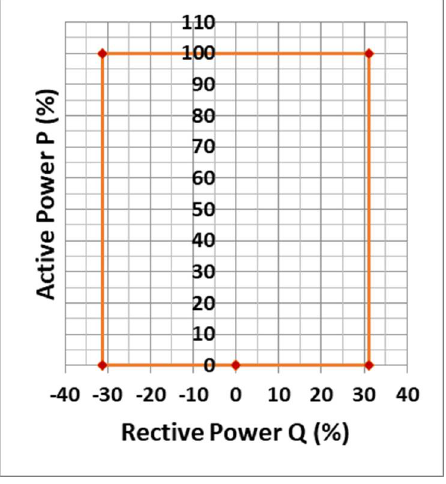
Figure 2. PV system configuration.